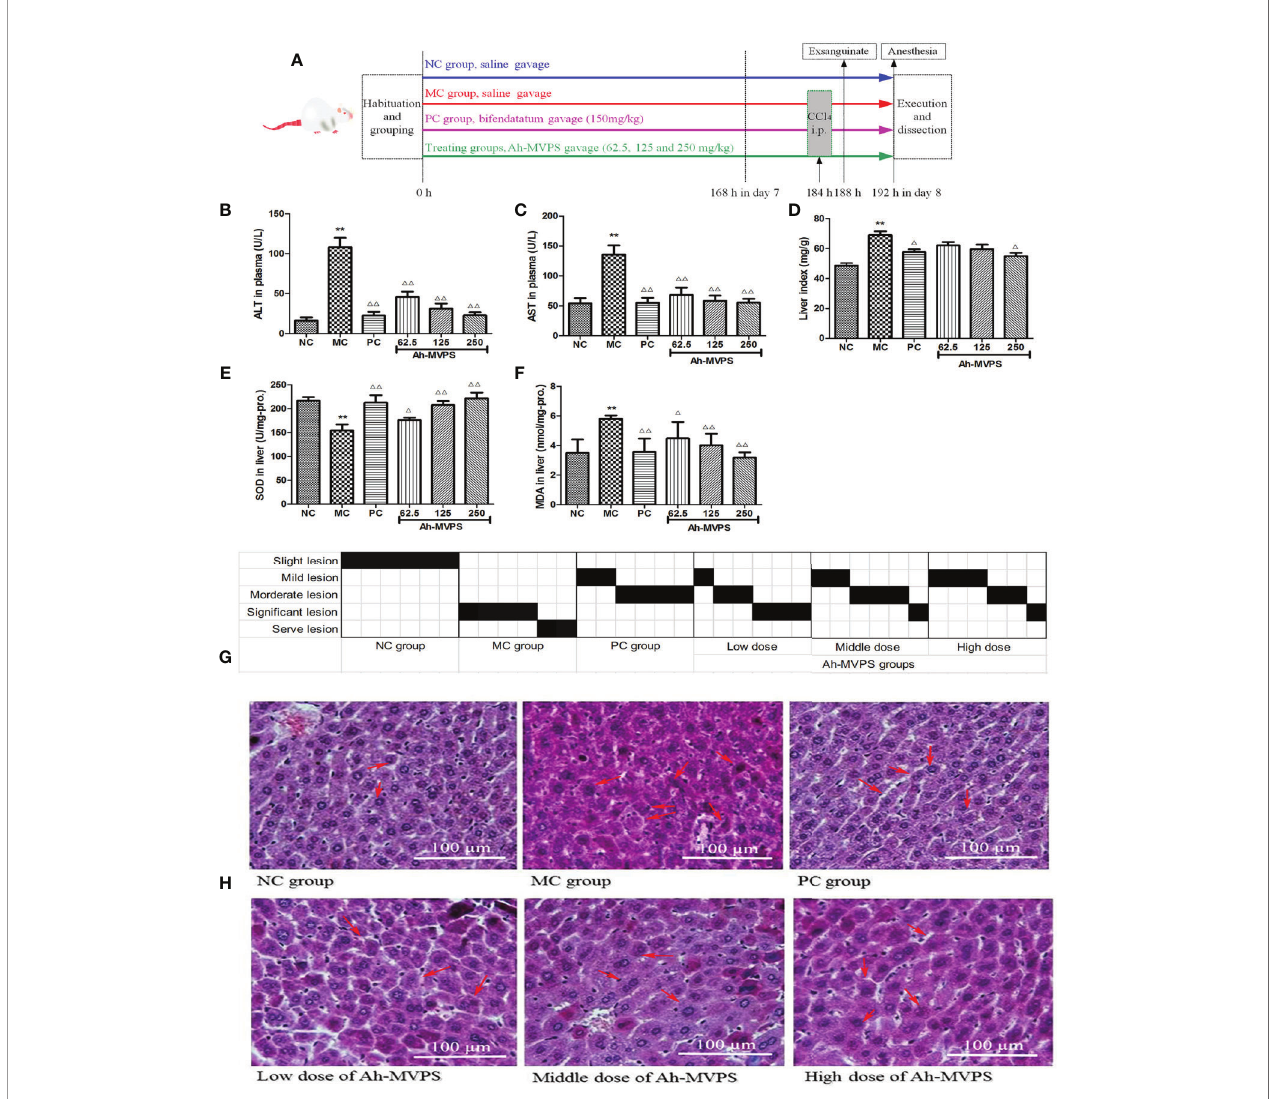
FIGURE 2 | Protective effects of Ah-MVPS on the injury of mouse liver induced by CCl 4 . The time protocols of animal disease model setting and administration (A) . Comparative analysis of ALT (serum alanine aminotransferase, B ), AST (aspartate transaminase, C ), LI (liver index, D ), SOD (superoxide dismutase, E ), and MDA (malondialdehyde, F ) of mice in each group, **P < 0.01 vs. normal control (NC) group, D P < 0.05, DD P < 0.01 vs. model control (MC) group. Recording table of pathological scoring (G) , and typical H&E section images (H) of mouse liver tissues (400-fold magni fi cation); red arrows indicate normal and/or injured